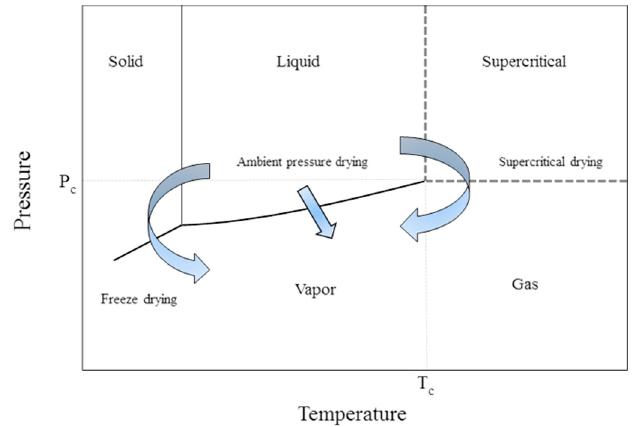
Figure 2. Phase diagram of a pure substance illustrating different drying routes. Adopted with permission from [10].